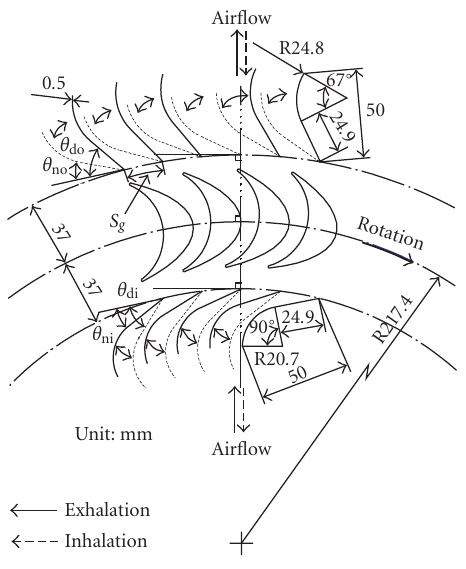
Figure 3: Configuration of